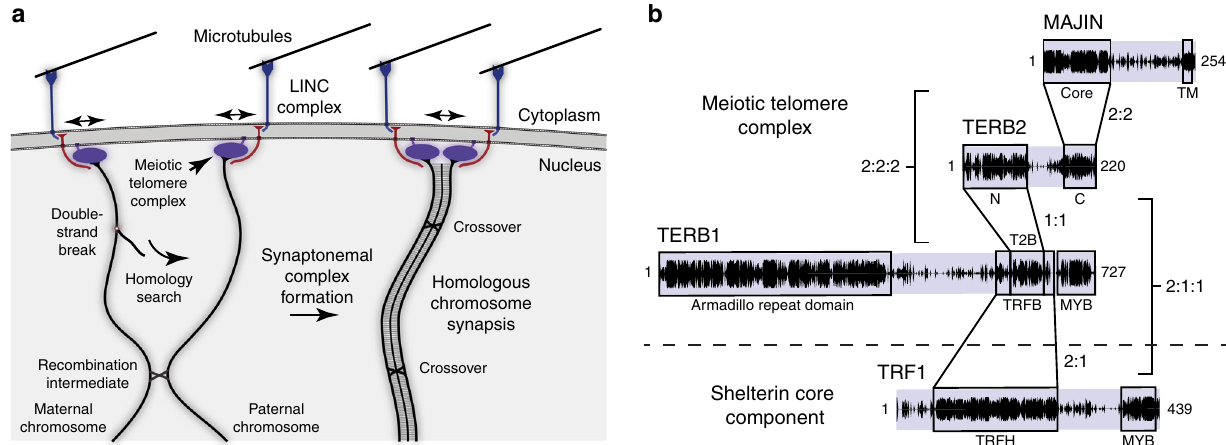
Fig. 1 Rapid prophase chromosomal movements through meiotic telomere-nuclear envelope tethering. a Meiotic chromosome telomere ends are tethered to the nuclear envelope by the meiotic telomere complex, enabling the transmission of cytoskeletal forces from microtubules to chromosome ends through LINC complexes. This produces rapid prophase chromosomal movements that are thought to facilitate recombination-mediated homology searches to generate inter-homologue recombination intermediates. The resulting pairings mature into synapsis through synaptonemal complex assembly, leading to crossover formation and the generation of single end attachment plates between synapsed telomere ends and the nuclear envelope. b Schematic of the domain structure and sequence conservation of human meiotic telomere complex proteins MAJIN, TERB1 and TERB2, and shelterin component TRF1. Amino acid conservation is illustrated as black plots in which the plot height represents the per residue conservation score. Sequences are annotated with their domain structure, interacting regions and oligomer states based on previous reports 42 – 45 and the results presented herein. MAJIN contains an N- terminal globular core (amino acids 1 – 112) that interacts with the TERB2 C-terminus (amino acids 168 – 220). The TERB2 N-terminus (amino acids 1 – 107) interacts with the TERB2-binding (T2B) site of TERB1 (amino acids 585 – 642), which is fl anked by a wider TRF1-binding (TRFB) site (amino acids 561 – 658) that interacts with the TRF homology (TRFH) domain of TRF1 (amino acids 62 – 268). MAJIN contains a C-terminal transmembrane (TM) helix, whilst TERB1 and TRF1 both contain C-terminal DNA-binding MYB